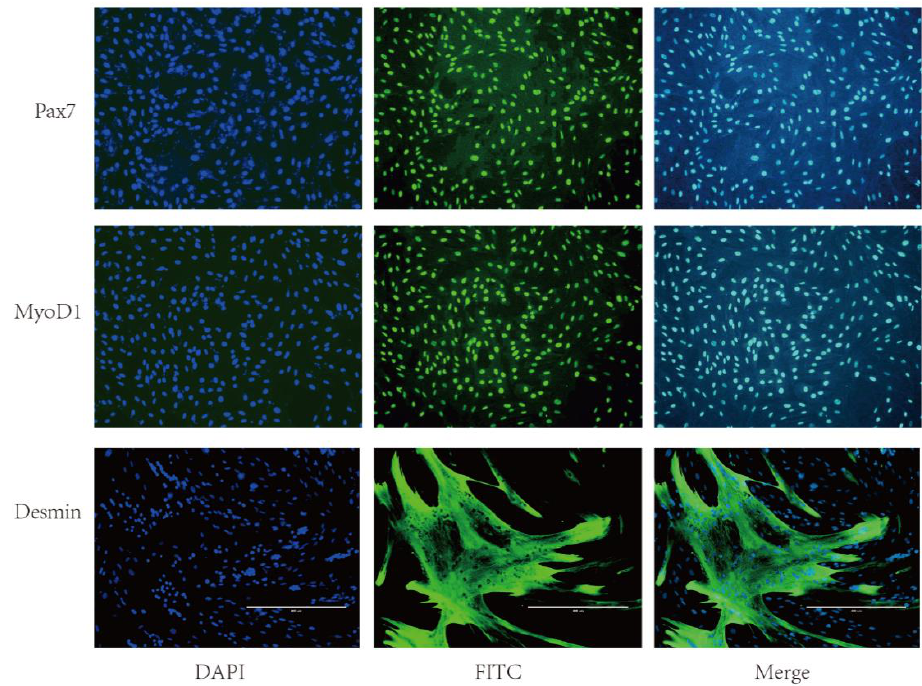
Figure 1. The expression of Pax7 , MyoD1 , and Desmin in SMSCs (scale: 1 bar represents 400